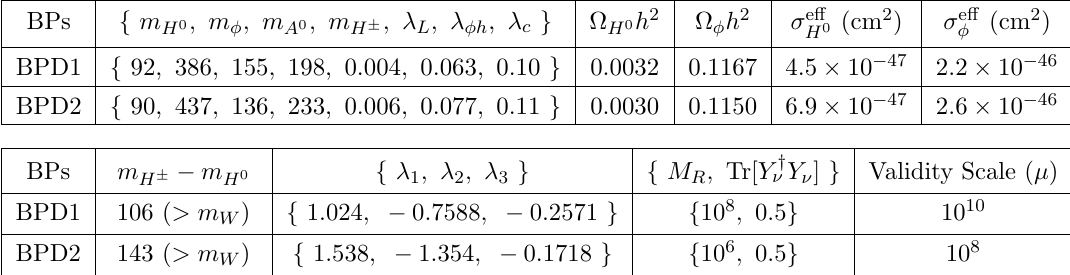
Table 5 . DM masses, quartic couplings, relic densities and spin independent e(cid:11)ective DM-neucleon cross-section of selected benchmark points for collider study. All benchmark points chosen here have m (cid:0) m > m for on-shell production of W (cid:6) . The maximum scale ( (cid:22) ) of Higgs vacuum H 0 H (cid:6) W (cid:6) satability and peturbativity in presence of right handed neutrinos are also noted. All masses and scales are in GeV.